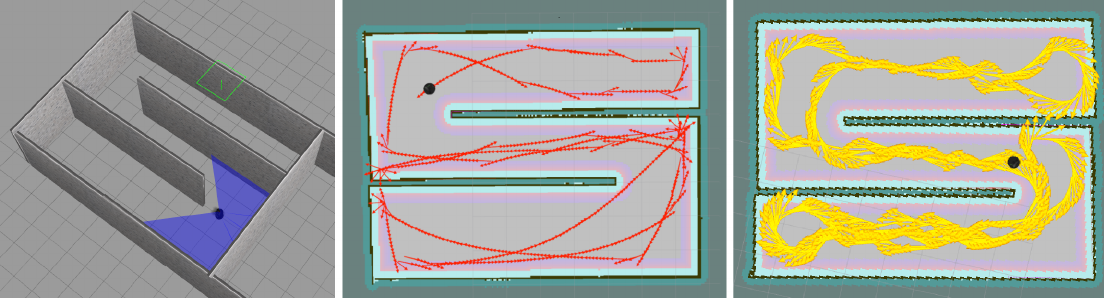
Figure 6. From ( left ) to ( right ), first image shows the robot simulated in Gazebo in a simple environment. The second image shows the robot movements using discrete actions visualized by SLAM after robot learned an optimal deep Q-Learning policy autonomously. The third image shown the robot movements using continuous actions visualized by SLAM after robot learned an optimal deep Actor-Critic